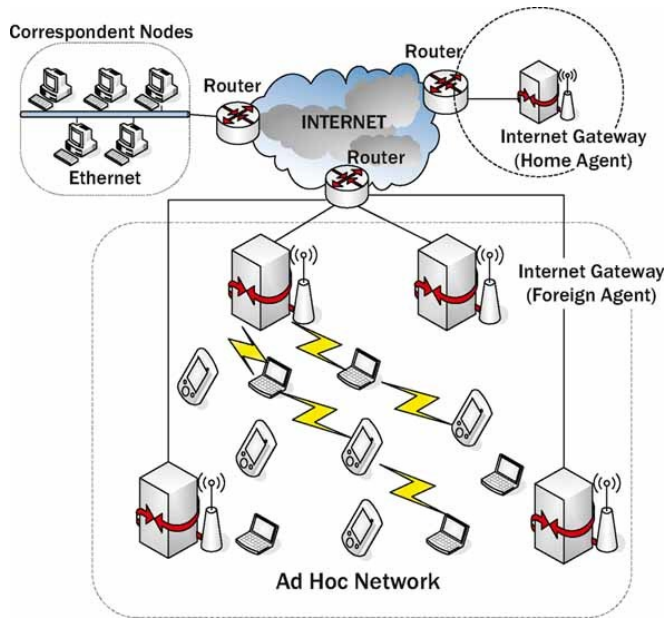
Figure 9. Integrating DSR-based mobile ad hoc networks with the internet [41].